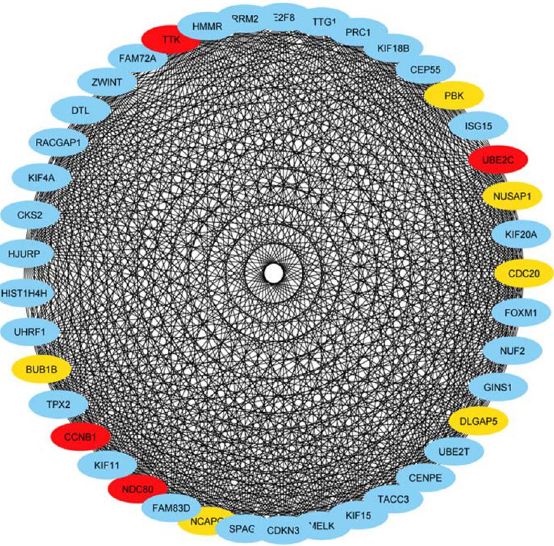
Figure 1. The interaction networks for down-regulated genes as predicted by STRING and visualized in Cytoscape. Hub genes and their neighbors are